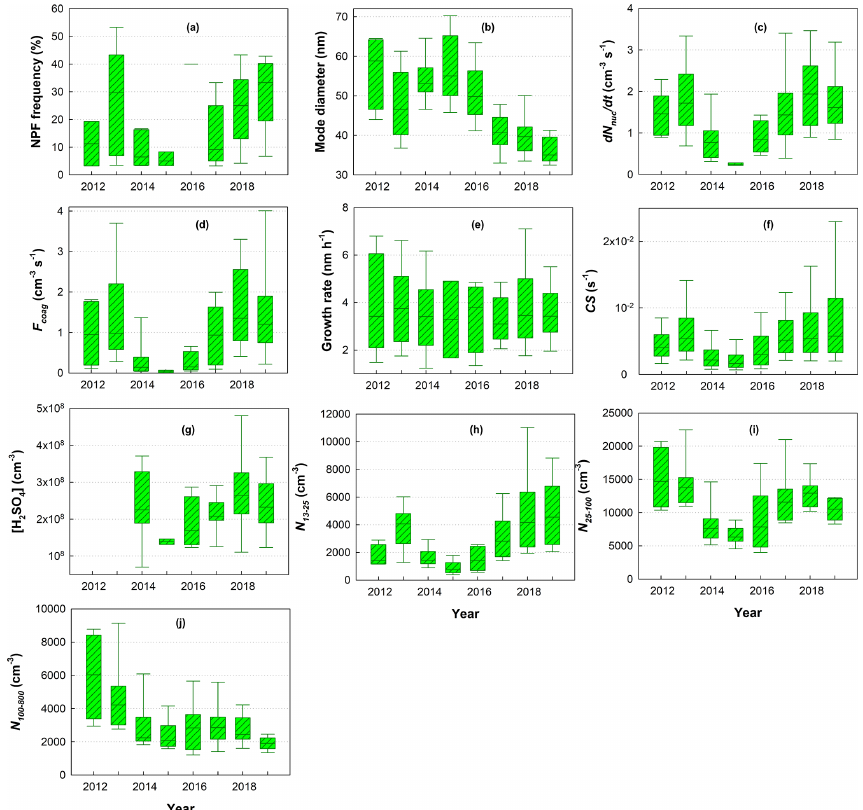
Figure 11. Inter-annual statistics of the trends of NPF frequency, mode diameter, formation (d N nuc / d t , F coag ) and growth rates, CS and H 2 SO 4 proxy, and number concentrations in the three bins ( N 13 − 25 , N 25 − 100 , N 100 − 800 ) during the campaign. The lines inside the box denote the median slope; the two whiskers and the top and bottom of the box denote the 5th and 95th and the 75th and 25th percentiles.